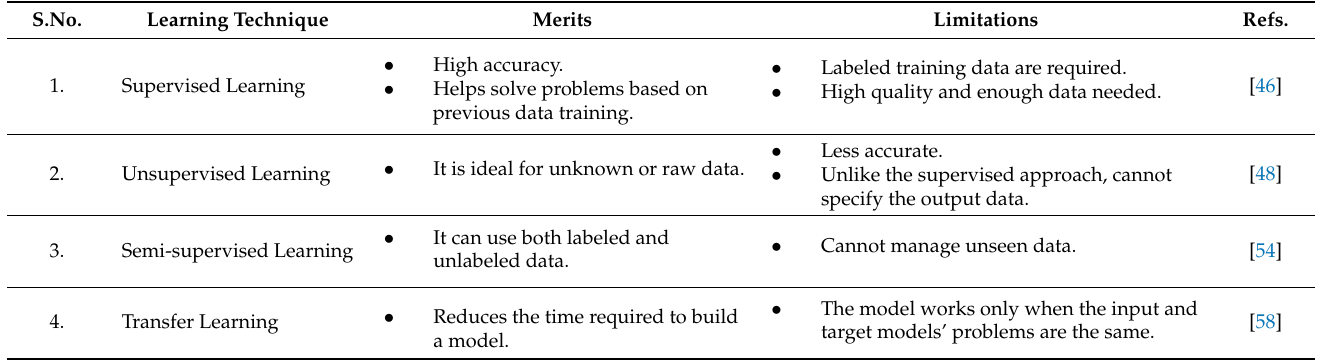
Table 2. Merits and limitations of the various machine learning techniques used in TB diagnosis. S.No. Learning Technique Merits Limitations